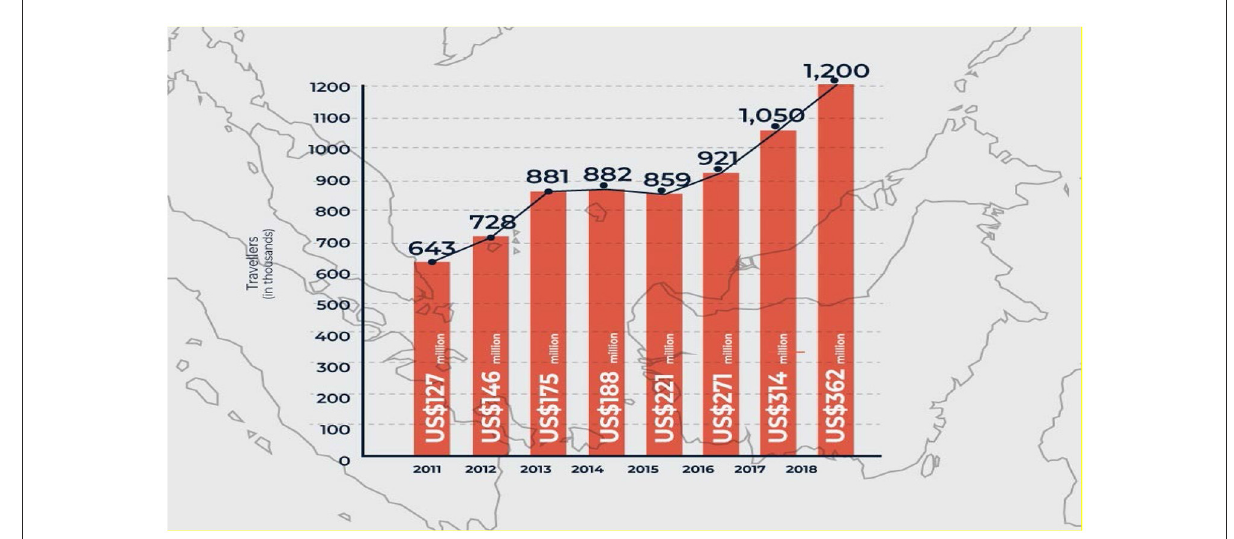
FIGURE1 Health Tourism Market in Malaysia. Source: The Malaysia Healthcare Travel Council (MHTC), 2019.